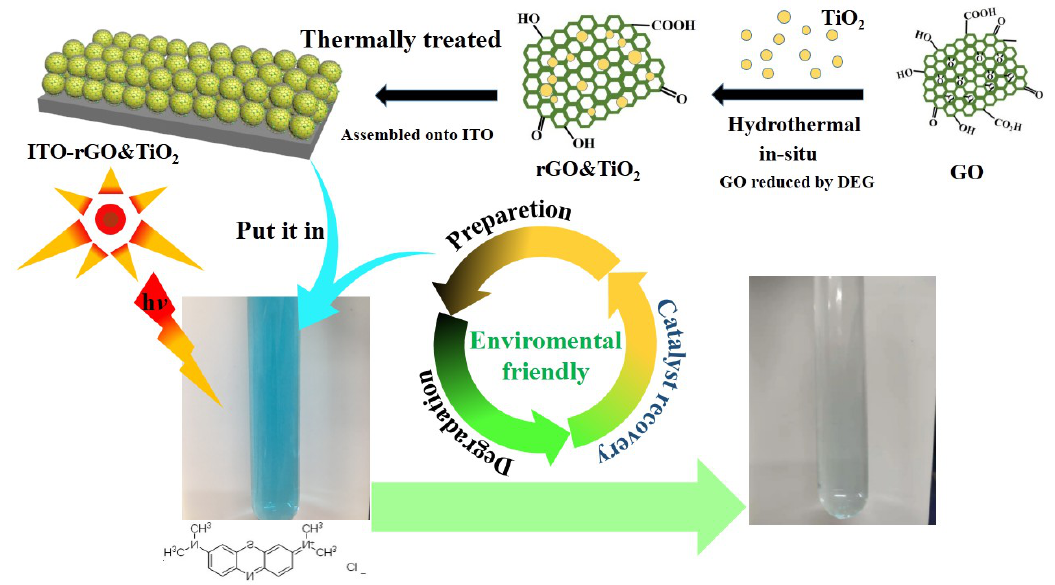
Figure 1. The preparation of ITO-reduced graphene oxide (rGO) and titanium dioxide (TiO 2 ) and photocatalytic processes.